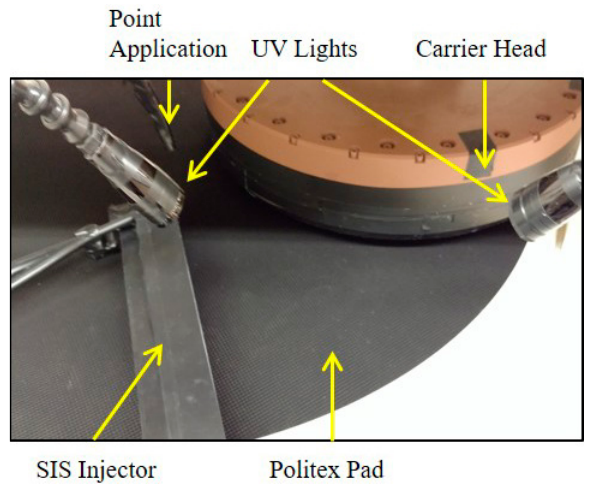
Figure 2. Experimental setup for ultraviolet enhanced fluorescence (UVEF) on an Araca APD-800 Polisher.